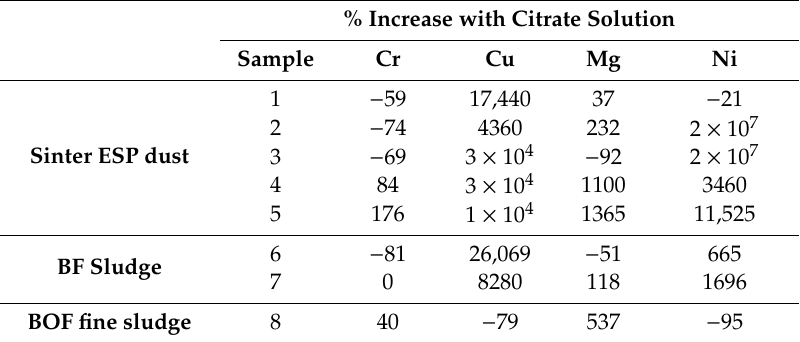
Table 3. Percentage increase* of key constituents after citrate